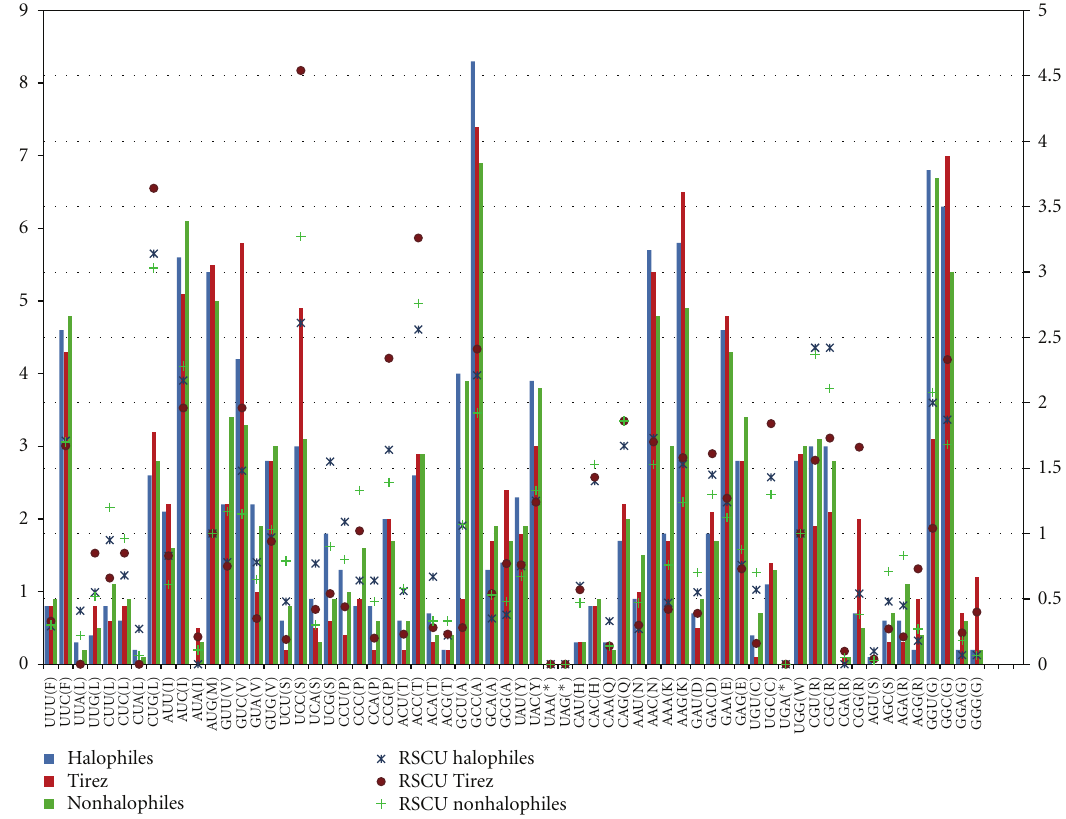
Figure 7: Correspondence analysis of relative synonymous codon usage (RSCU) for AprA sequences from halophiles, nonhalophiles, and Tirez phylotypes. The distribution of all codons (including the start and stop codons ∗ ) for every amino acid across the three datasets is shown on the X -axis. The frequency of each codon (%) is represented with bars on the left Y -axis. RSCU values for each codon across the three datasets are represented with di ff erentiated dots on the right Y -axis. In the absence of any codon usage bias, the RSCU value would be 1.00. A codon that is used less frequently than expected will have a value of less than 1.00 and vice versa for a codon that is used more frequently than